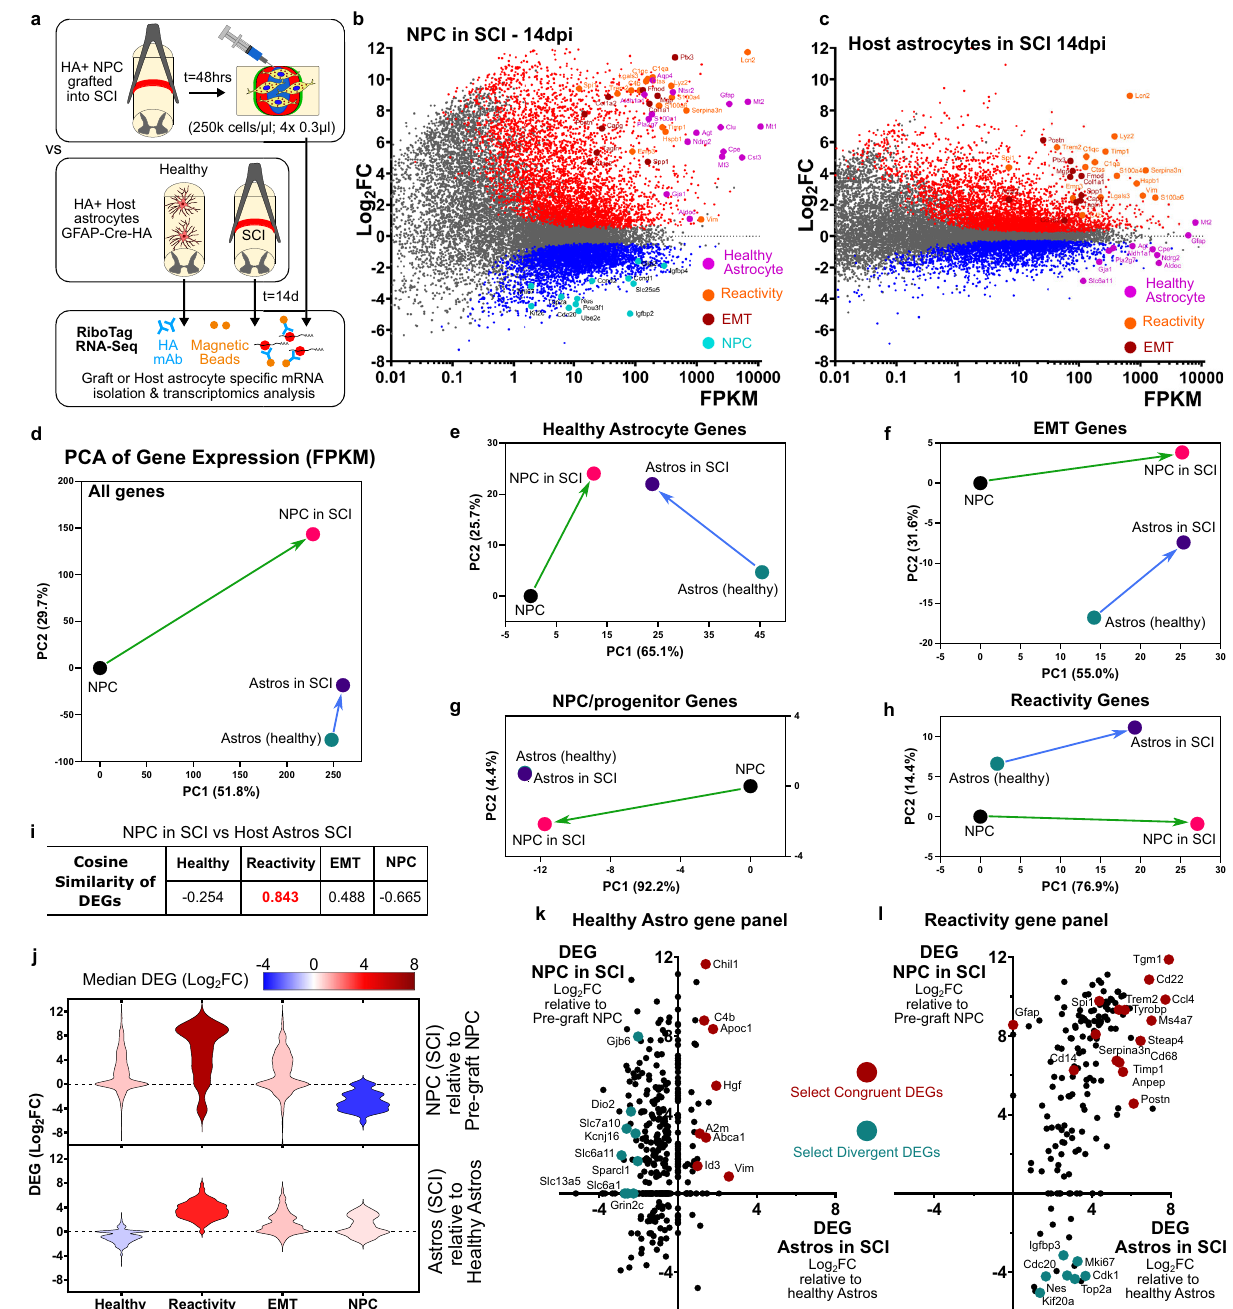
Fig. 7 | Astroglia derived from NPC grafted into SCI exhibit similar astroglial reactivitystatestohostastrocytesrespondingtoSCI.a Schematicsummarizing experimentalapproach for evaluating transcriptomes of NPCgrafted into SCI with host astrocytes responding to SCI. b M-A Plot of grafted NPC ( N =5 samples) recovered at 2 weeks post injury (14dpi) compared to pre-grafted NPC ( N =5 samples) showing increased expression of healthy astrocyte, reactivity, and EMTgenesanddecreasedexpressionofNPC/proliferationgenes. c MA-Plotofhost astrocytes at 14 days after SCI showing comparable upregulation of reactivity and EMTgenesbut decreased expressionof healthy astrocyte genes. PCAs using FPKM values comparing state changes between NPC before and after grafting into SCI (recovered at 14dpi) and host astrocytes before and 14 days after SCI for all expressedgenes( d )aswellasusinggenepanelsforhealthyastrocytes( e ),EMT( f ),